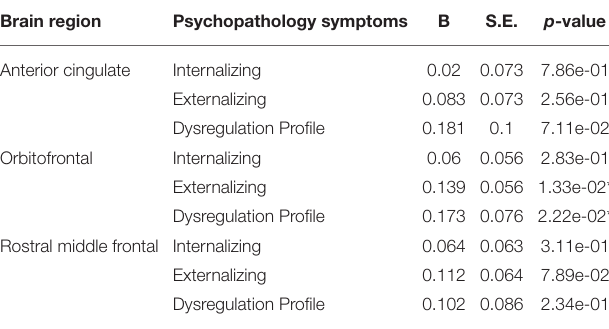
TABLE 3 | Hypothesis driven cortical thickness model